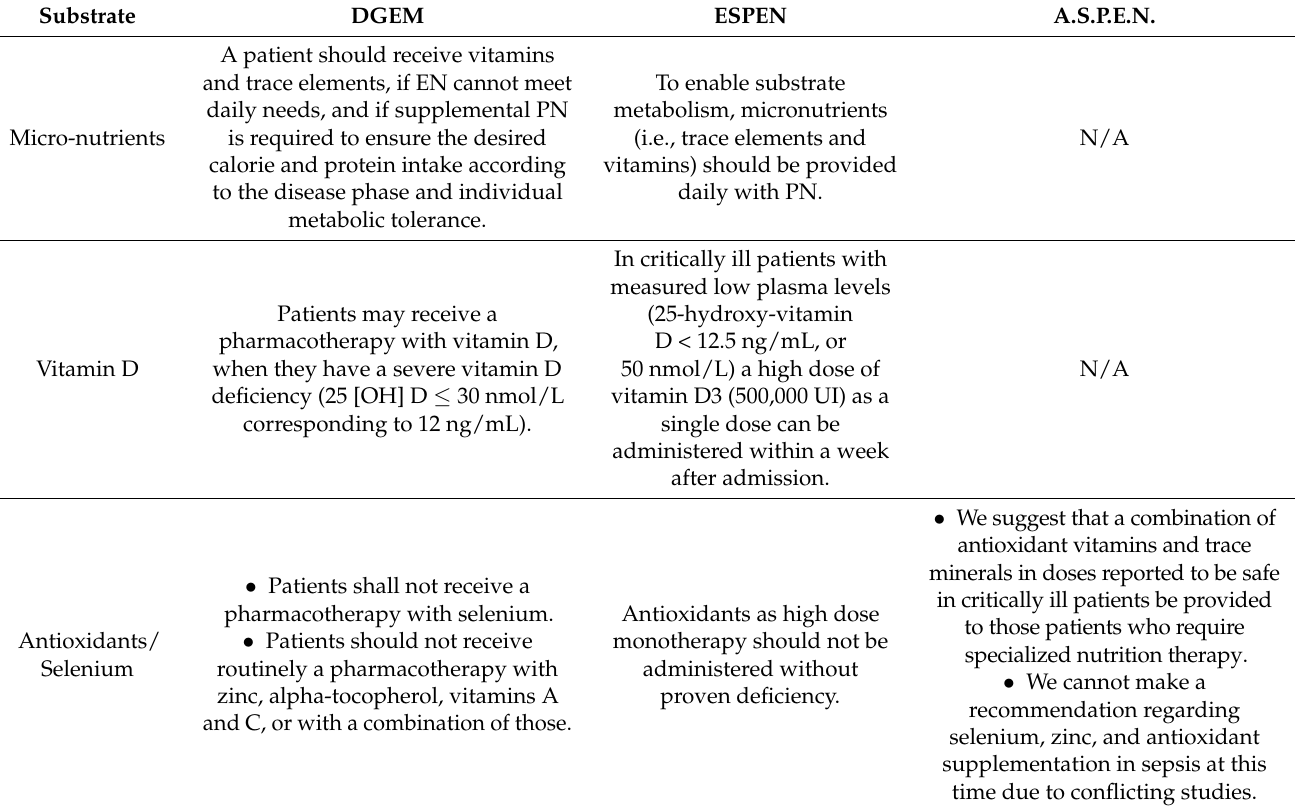
Table 1. Current guideline recommendation regarding micronutrients, vitamins, and